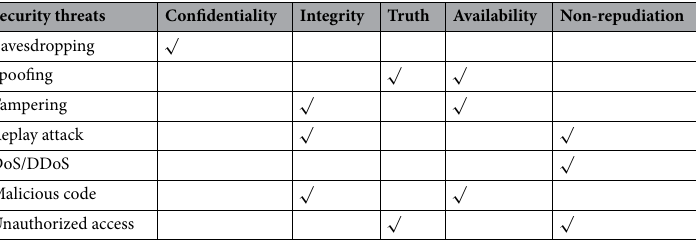
Table 1. The relationship between security threats and security requirements in SINs .